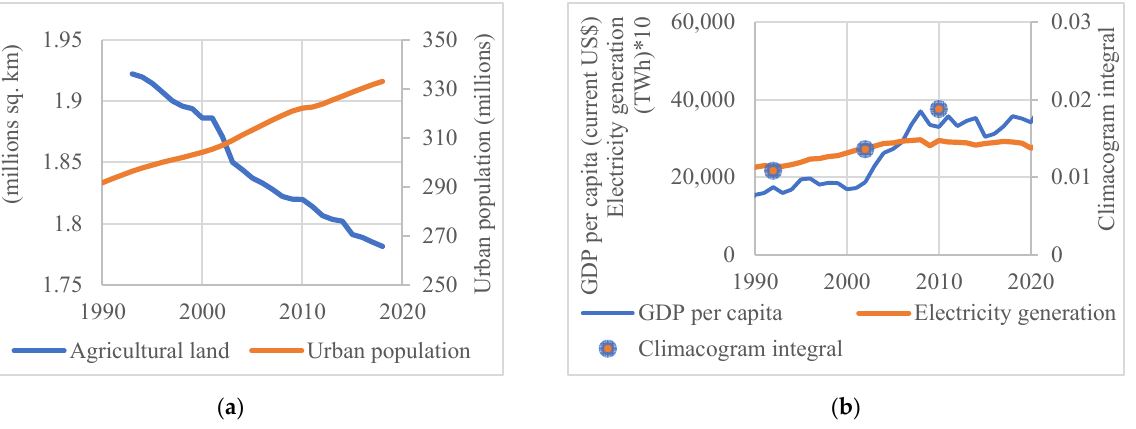
Figure 10. ( a ) Europe in Mercator projection. Night lights of Europe in Mercator projection: ( b ) 1992; ( c ) 2002; ( d ) 2012 [2,155].